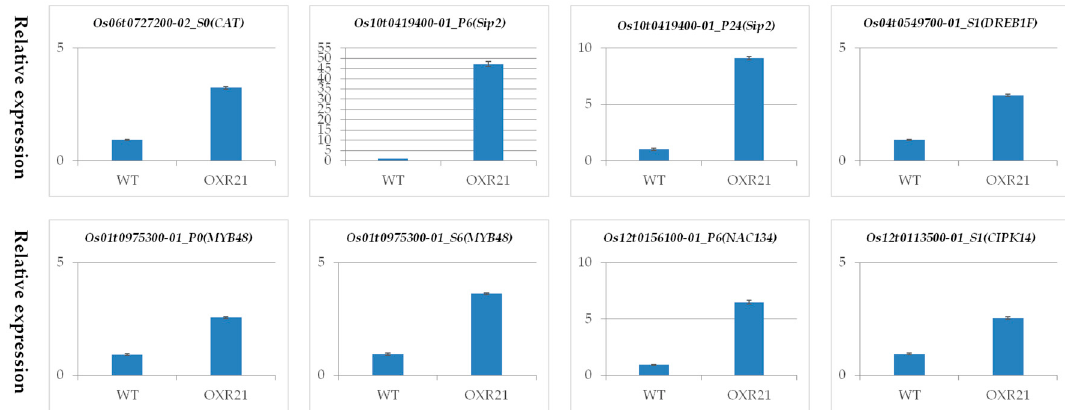
Figure 5. Quantitative PCR (qPCR) validation for DEGs identified by RNA-seq in the comparison between OXR21 and WT. S0, S1 and S6 represent salt treatment for 0, 1, and 6 h, respectively. P0, P6 and P24 represent PEG treatment for 0, 6, and 24 h, respectively.